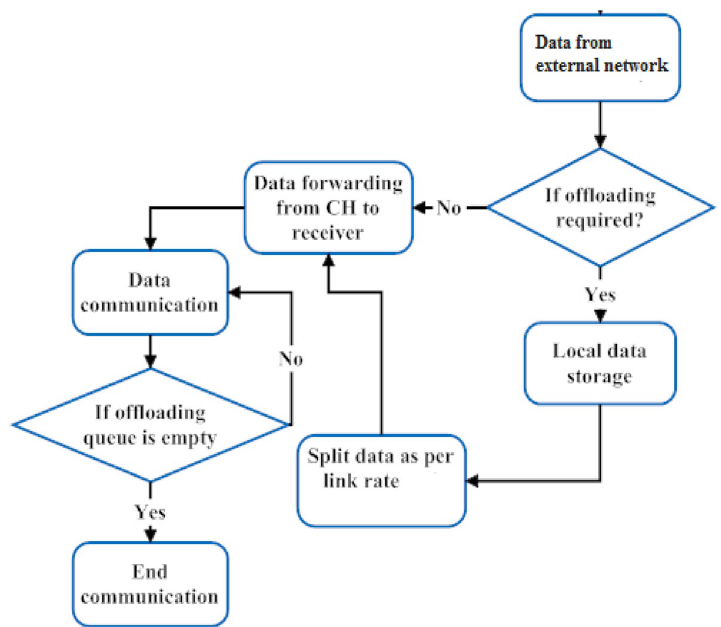
Fig. 3 Flow for proposed data offloading mechanism with energy efficient